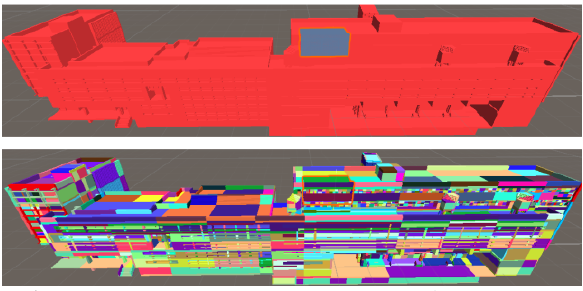
Figure 3 . Voxels visualisation using blocks of meshes; upper image shows voxelised model created from smaller mesh chunks; lower image shows mesh chunks colouring each voxel based on object’s id to which it belongs.